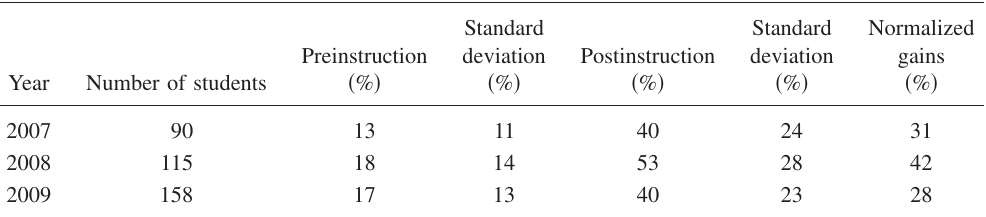
TABLE V. Average normalized gains for ILD teaching with Fundamentals students, for the three years, 2007–2009.